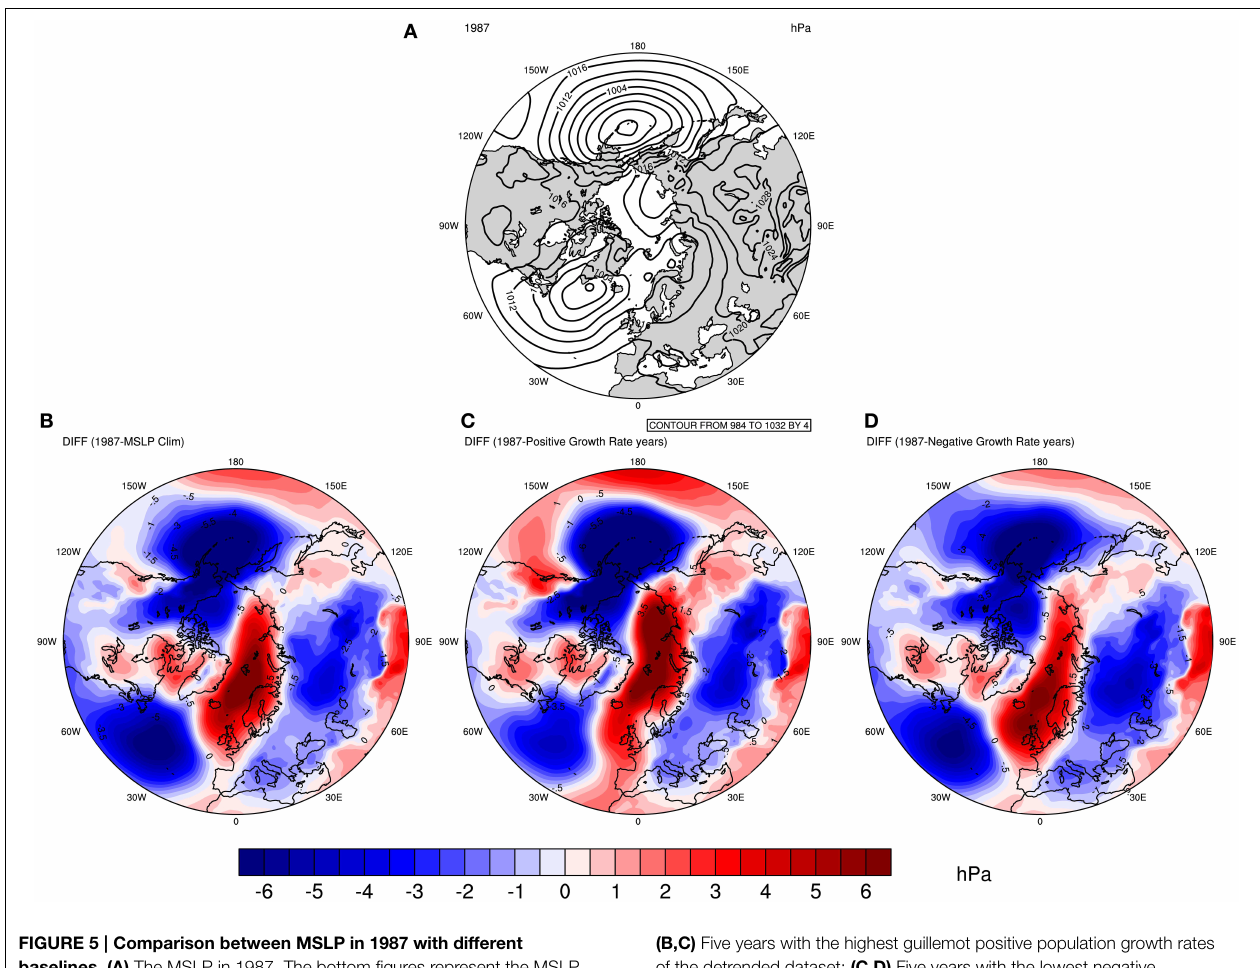
FIGURE 5 | Comparison between MSLP in 1987 with different baselines. (A) The MSLP in 1987. The bottom figures represent the MSLP in 1987 minus the MSLP in the following periods: (B) mean of 1980–2011;